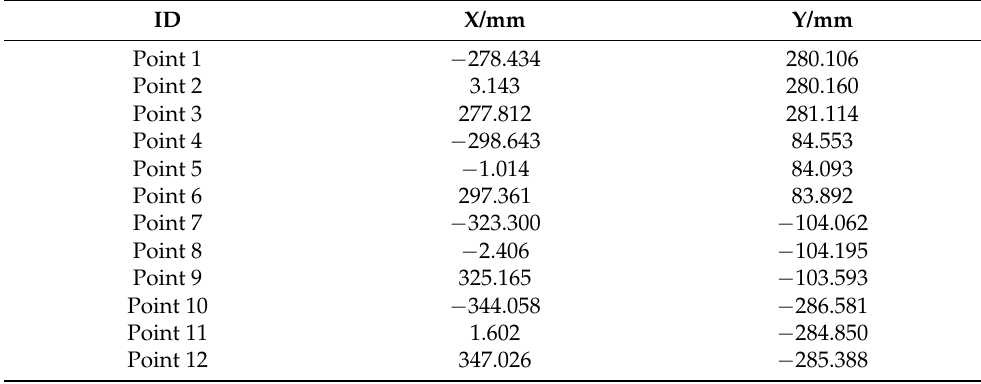
Figure 13. Key positions on the honeycomb panel. Table 4. X-Y positions of calibration points.